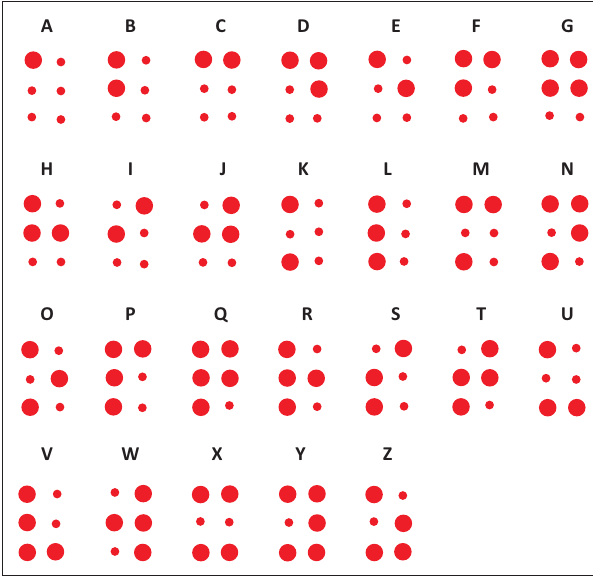
FIGURE 2: Uncontracted Grade 1 and contracted Grade 2 Braille